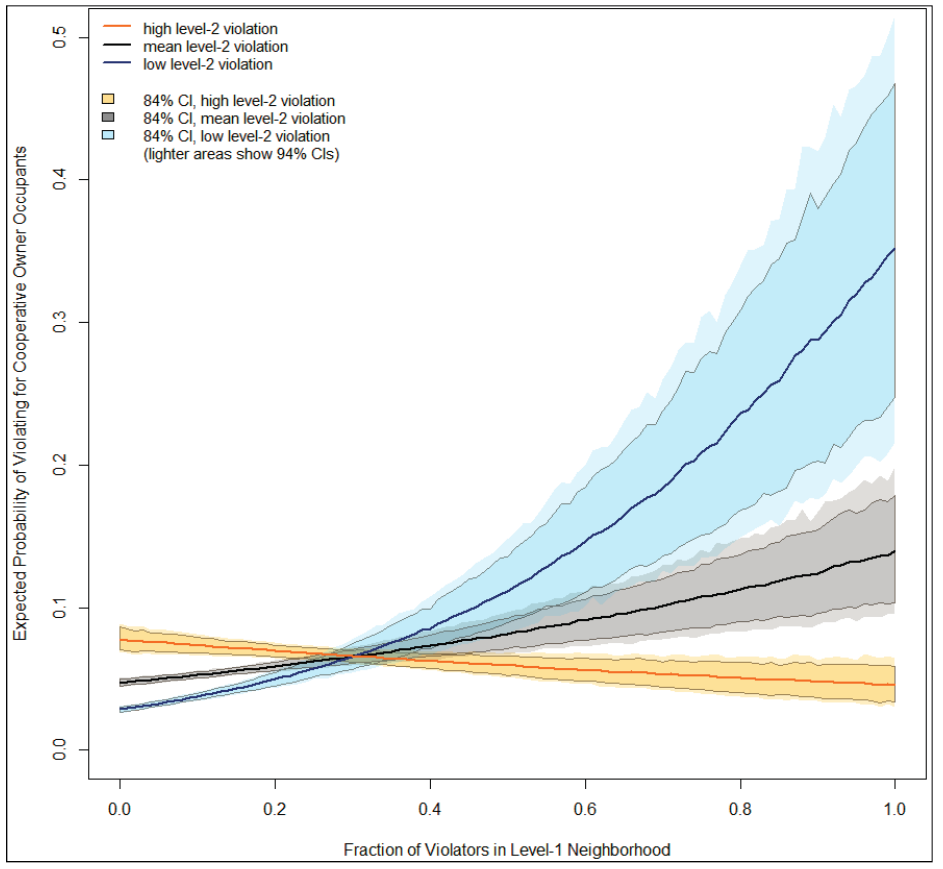
Figure 3. Simulating violation behavior for cooperative owner occupants in three level-2 neighborhood